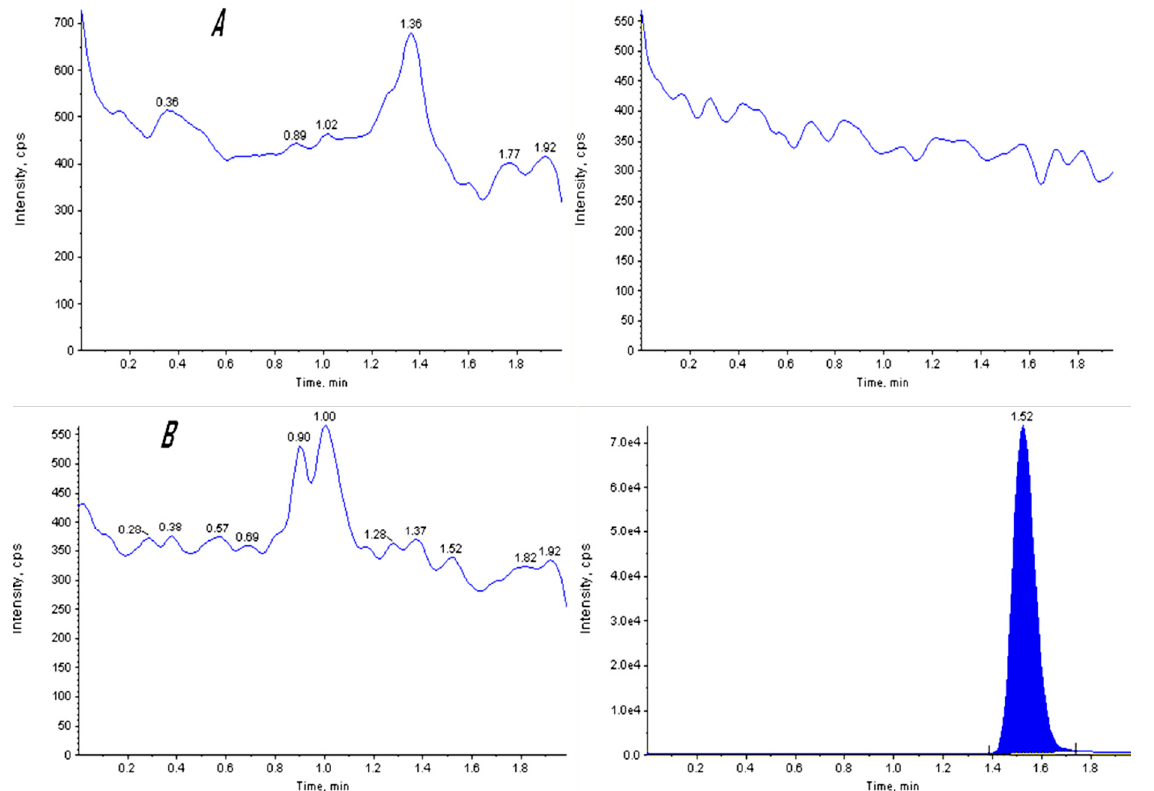
Figure 4. Representative chromatogram for selectivity of ( A ) blank standard and IS blank, and ( B ) zero standard and IS extract.